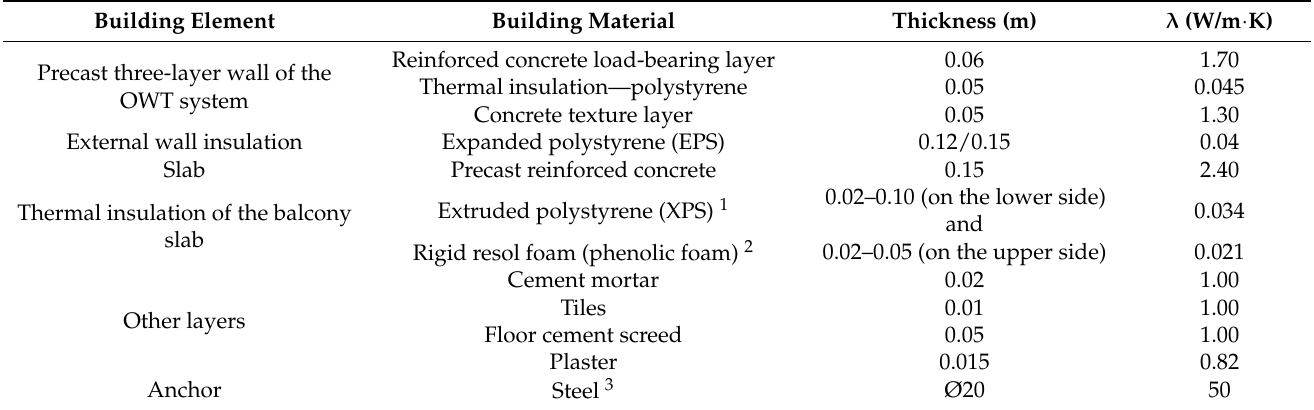
Table 2. Features of materials used in the scenarios